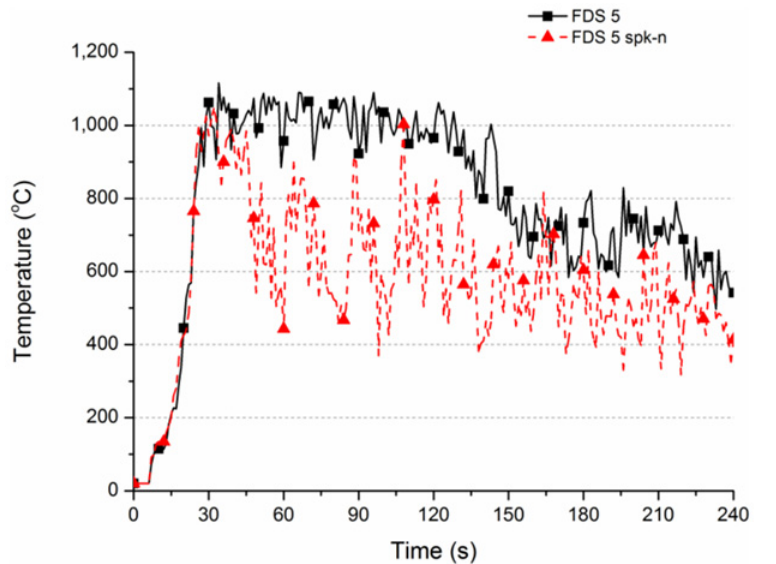
Fig 8. Temperature variation for different settings (for FDS Ver.5).